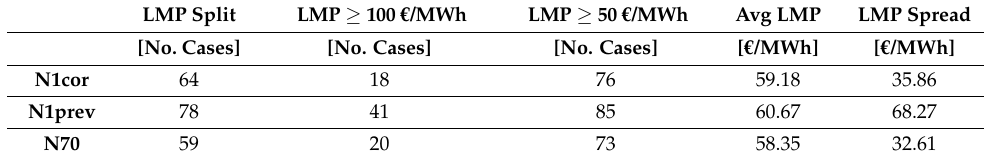
Figure 16. LMP profile over considered case: N70 scenario. Table 6. LMP statistics for all considered